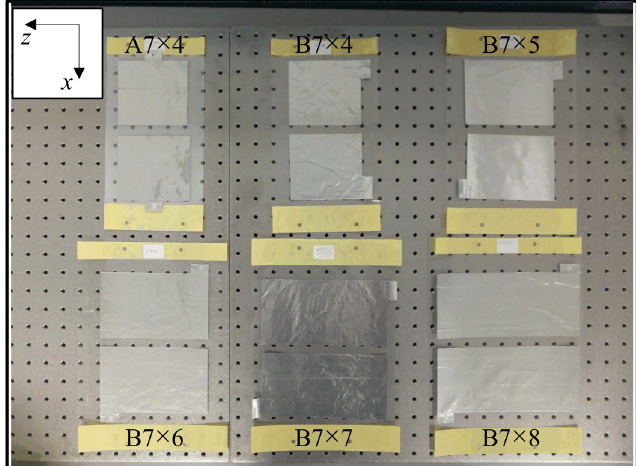
Figure 3. Photograph of the electroadhesion actuators. Naming convention: A7×4, the actuator with material Combination A with an electrode dimension of 7 inches in length and 4 inches in